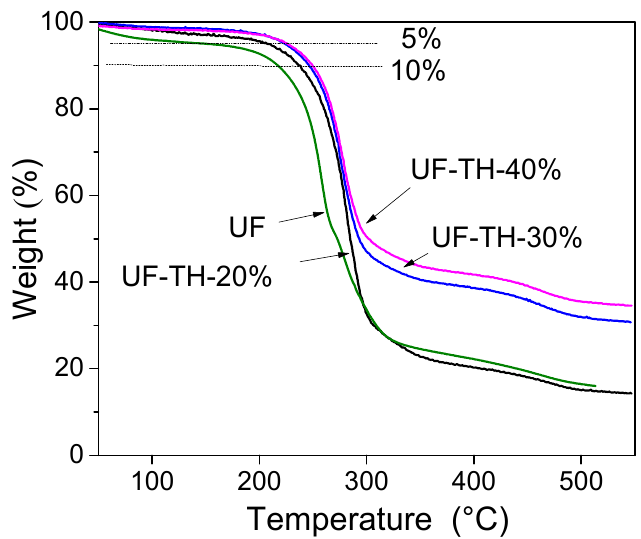
Figure 4. TGA curves of UF and UF/HNTs nanocomposites.